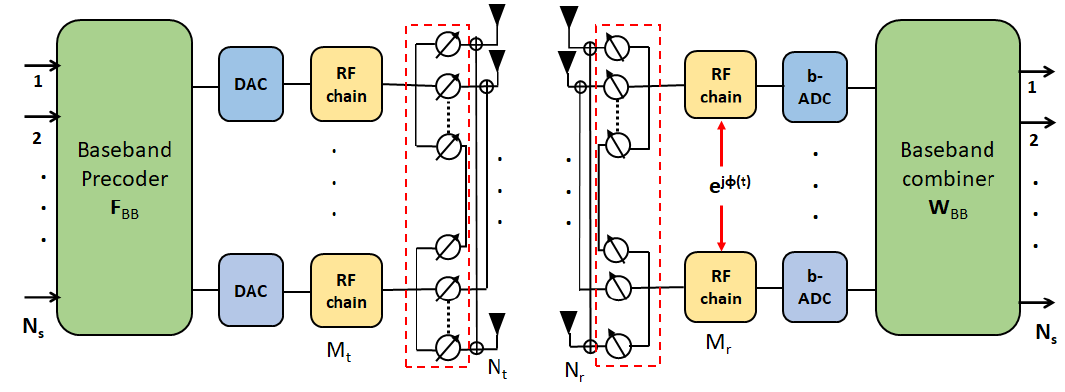
Figure 1. The diagram of the considered mmWave MIMO system model with non-ideal